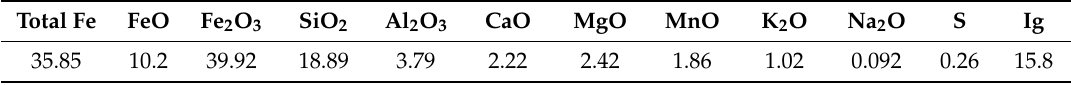
Table 1. Chemical Compositions and Ignition Loss of Limonite Ore (wt%).